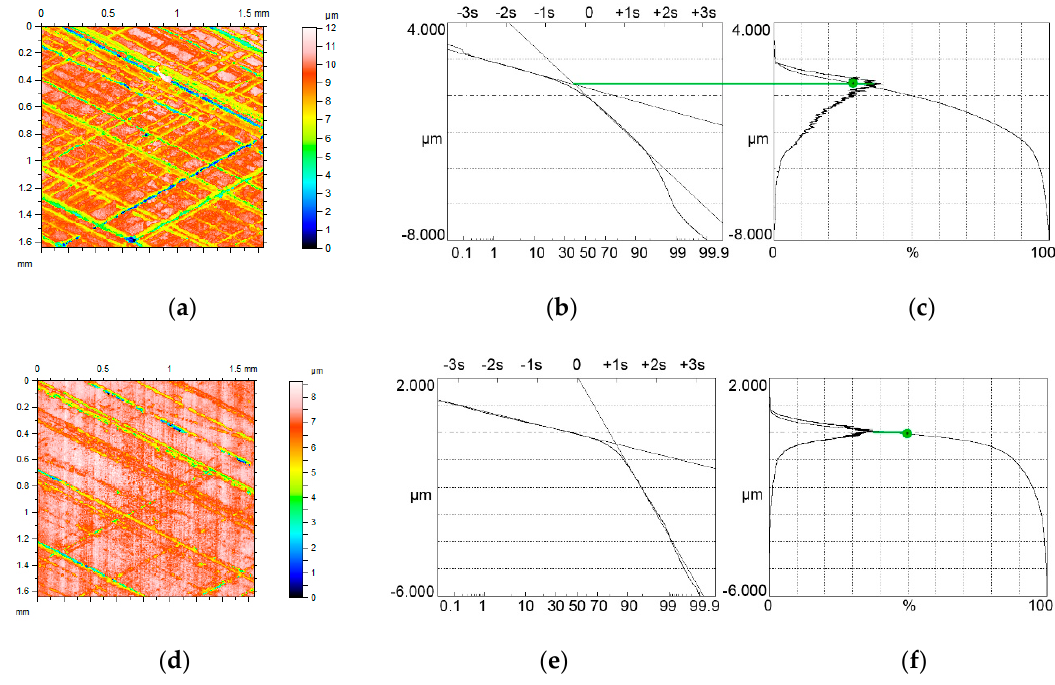
Figure 10. Contour plots ( a , d ) surface probability plot ( b , e ), material ratio curve and probability distribution ( c , f ) of two-process measured surfaces characterized by the following parameters: Spq = 0.61 µm, Svq = 2.04 µm, Smq = 38% ( a – c ) and Spq = 0.43 µm, Svq = 2.51 µm, Smq = 84%, both surfaces have unimodal ordinate distributions.